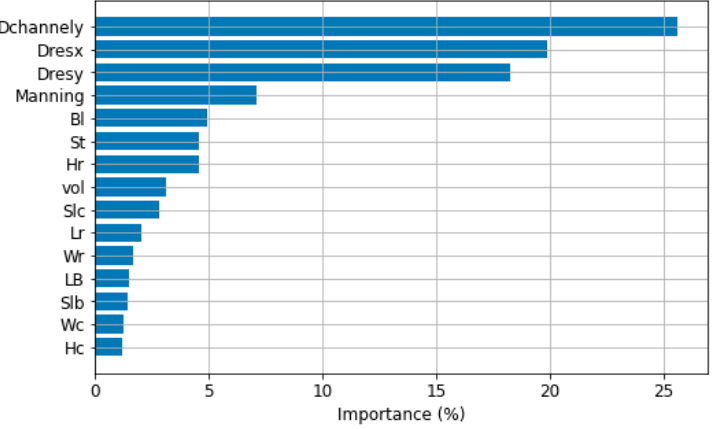
Figure 6. Importance of the parameters for the RF-US model.